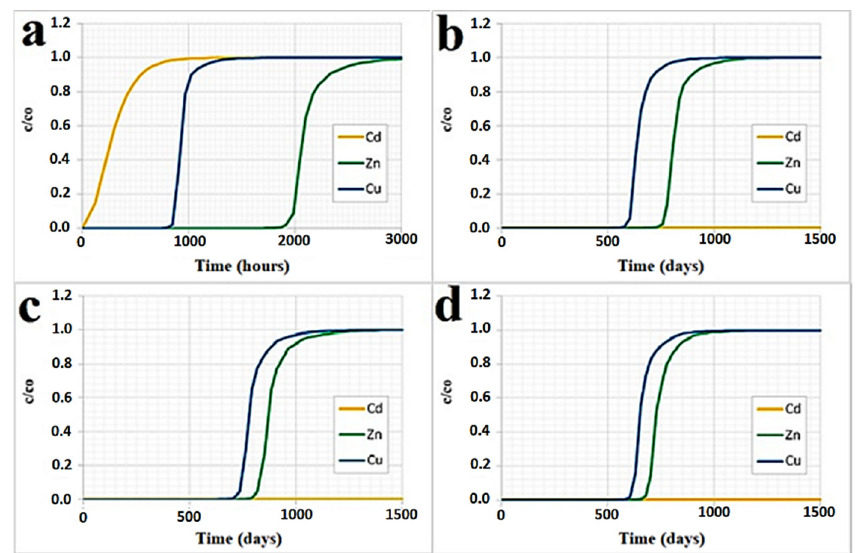
Figure 10. Adsorption trend and saturation times, simulated by the code RETRASO for all transition metals considered, respectively, in the case of: ( a ) cabuya fiber; ( b ) clinoptilolite natural zeolite; ( c ) mordenite natural zeolite; ( d ) sodium mordenite natural zeolite.